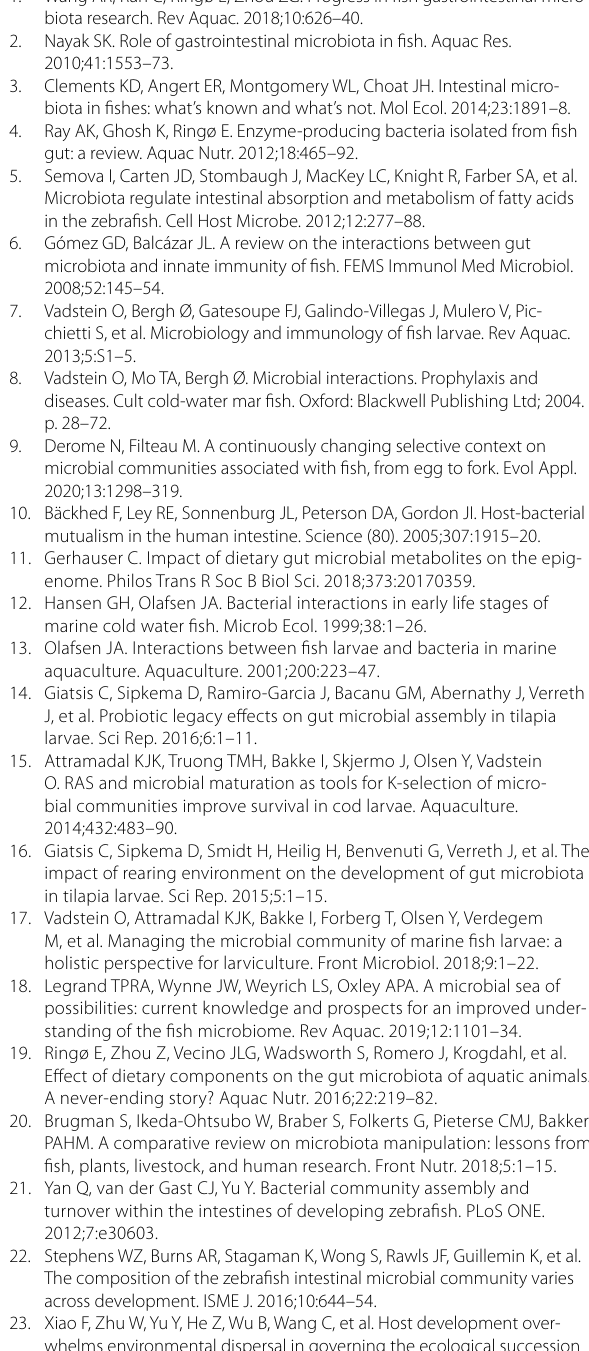
Table S6 . The apparent digestibility coefficient (ADC, %) of diet dur- ing Phase III (growth trial, 63-105 dof). Table S7 . Nitrogen and energy balances during Phase III (growth trial, 63-105 dof). Table S8 . DistLM marginal tests showing the correlation between growth, apparent digest-